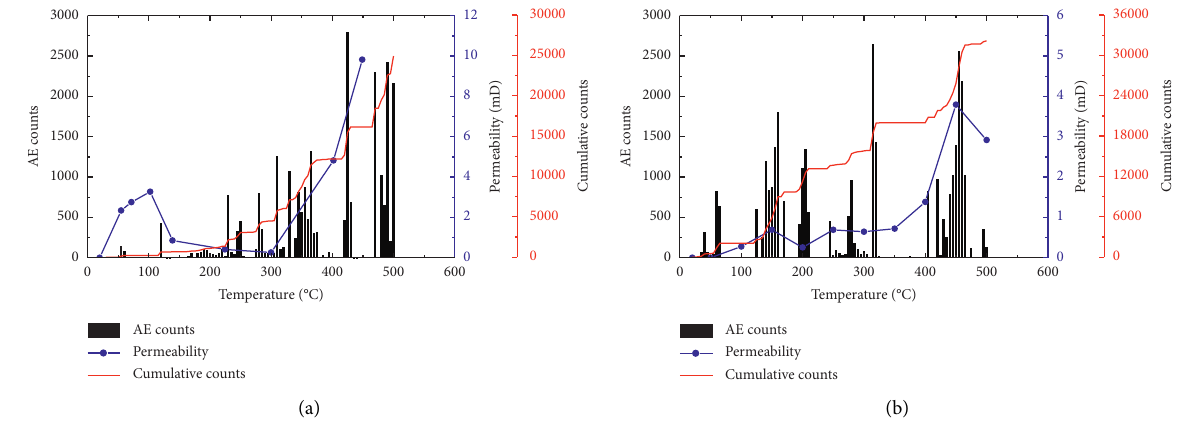
Figure 4: AE counts and permeability of two samples at high temperature and 3D stress. (a) Sample 1. (b) Sample 2.